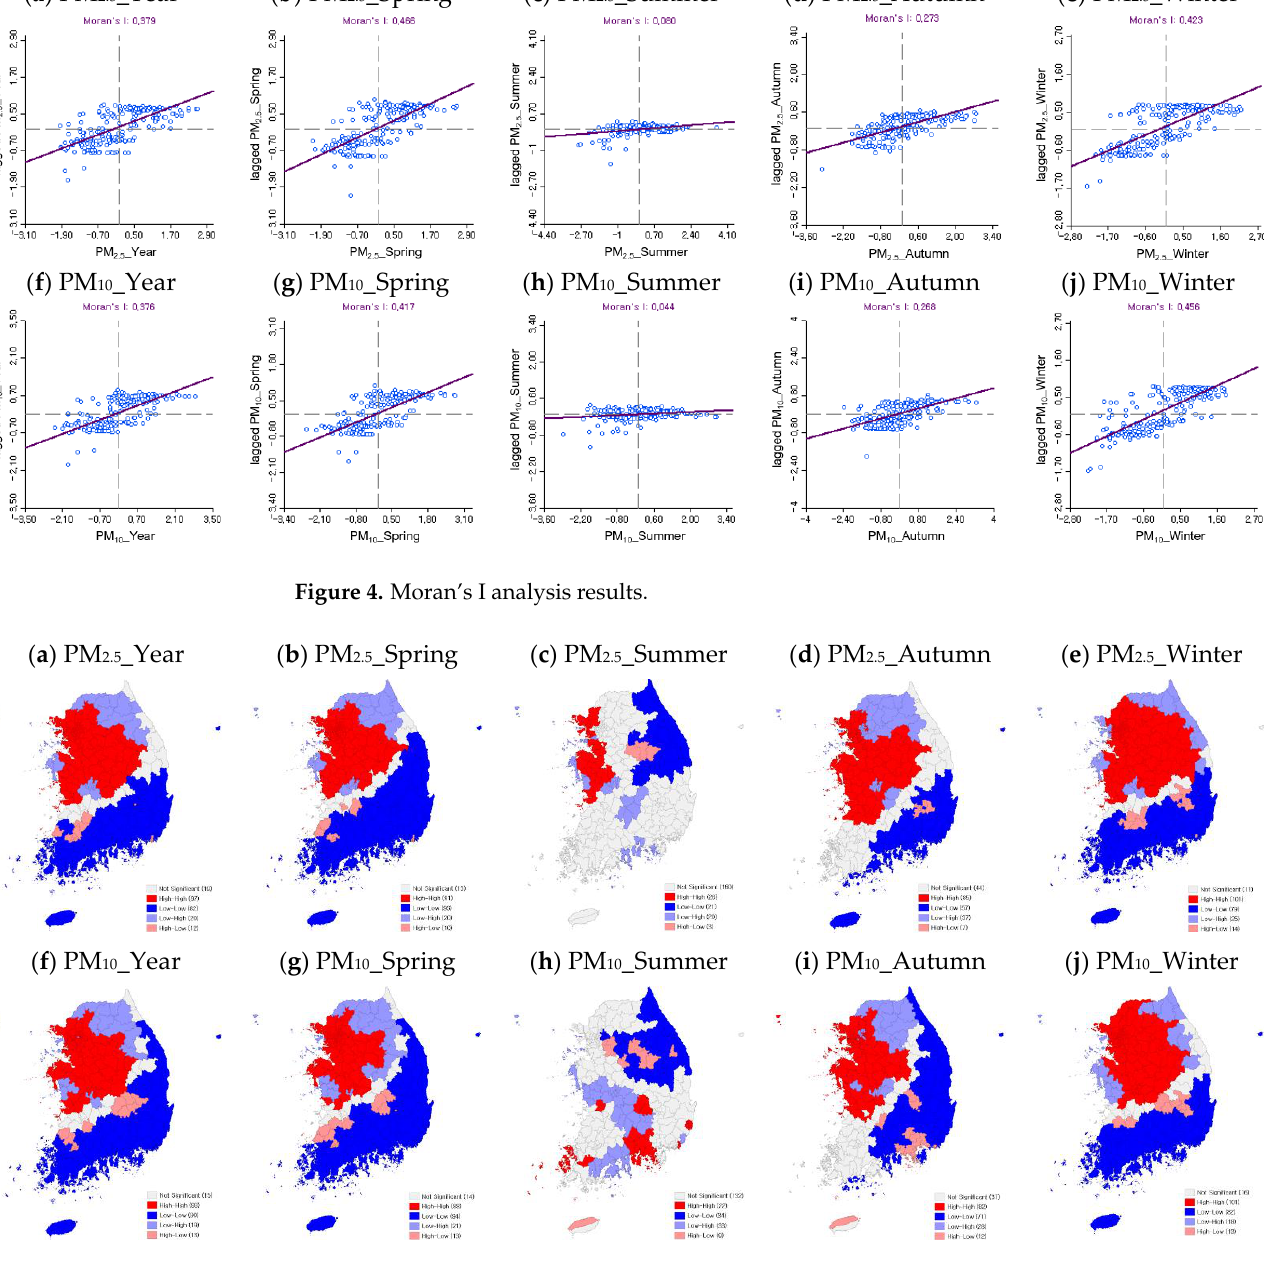
Figure 5. LISA analysis results .